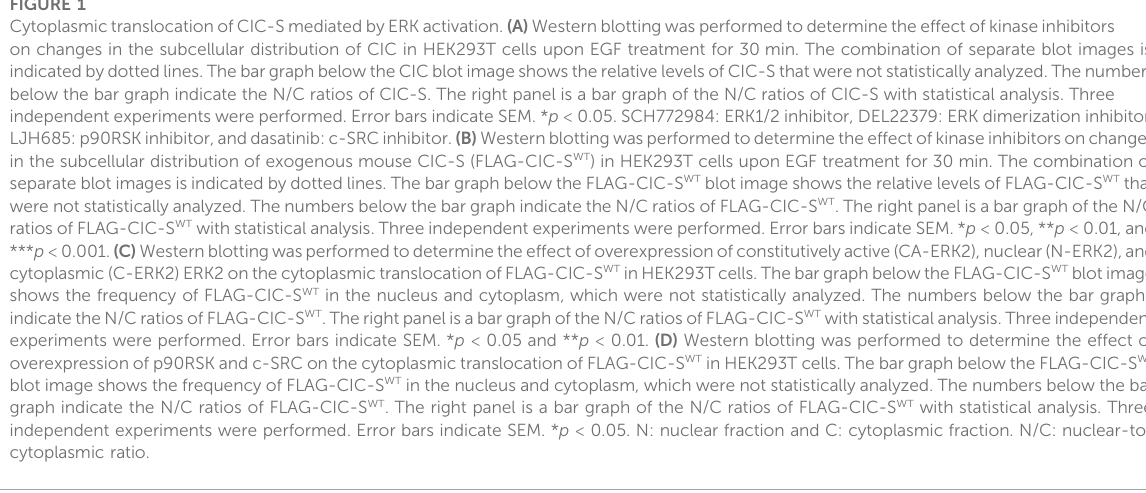
translocation of FLAG-CIC-S (Supplementary Figure S3A). ERK inhibition further inhibited the cytoplasmic translocation of FLAG-CIC-S H12A upon EGF treatment (Supplementary Figure S3B), which was consistent with the fi nding that ERK inhibition had a greater suppressive effect on this process than that of p90RSK (Figures 1A,B). Based on these results, we hypothesized that there are more ERK- mediated phosphorylation sites within CIC, which contribute to the EGF treatment-induced cytoplasmic translocation of CIC-S. EGF treatment induces phosphorylation of human CIC-S at